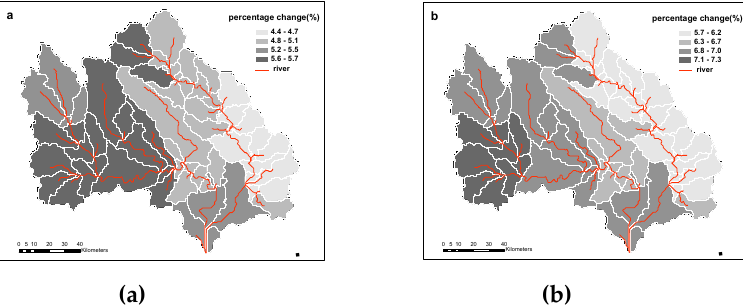
Figure 14. Spatial distribution of precipitation percentage changes under ( a ) 1.5 °C; ( b ) 2.0 °C warming scenarios.